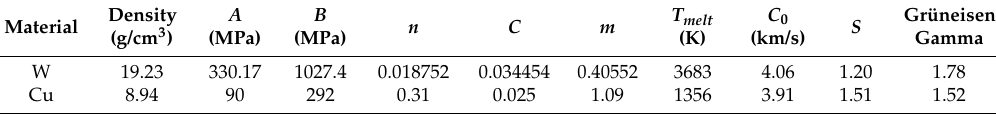
Table 4. Parameters of Johnson–Cook equation and Grüneisen EOS for W and Cu.